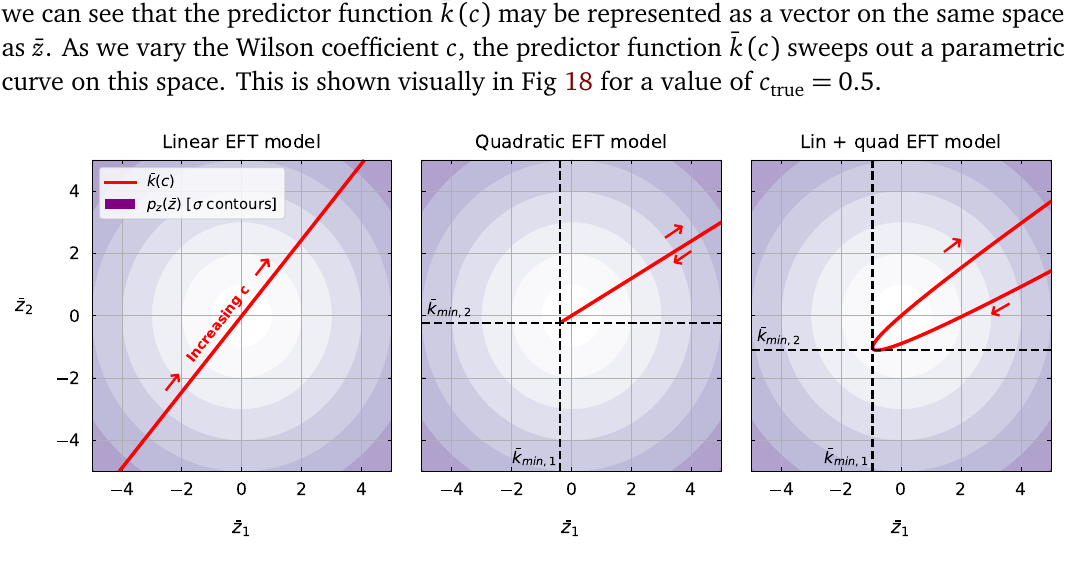
Figure 18: Visualisation of ¯ k ( c ) in a 2-dimensional ¯ z